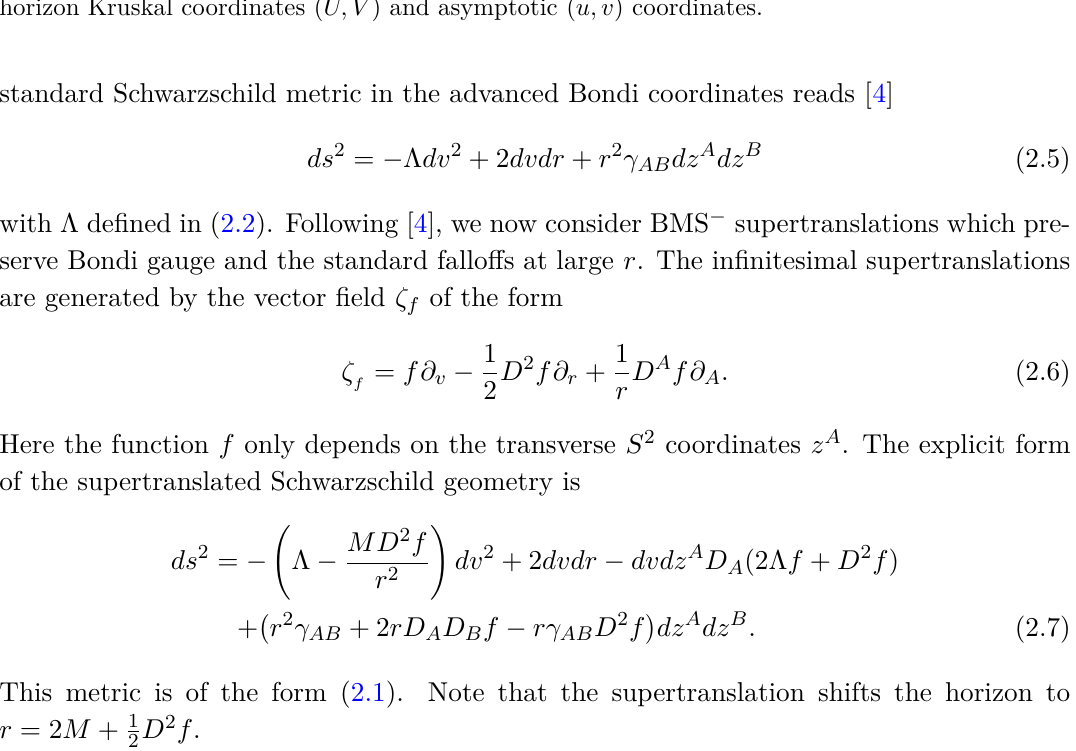
Figure 4. The soft hair degrees of freedom are encoded in the transition function f between near horizon Kruskal coordinates ( U, V ) and asymptotic ( u, v )